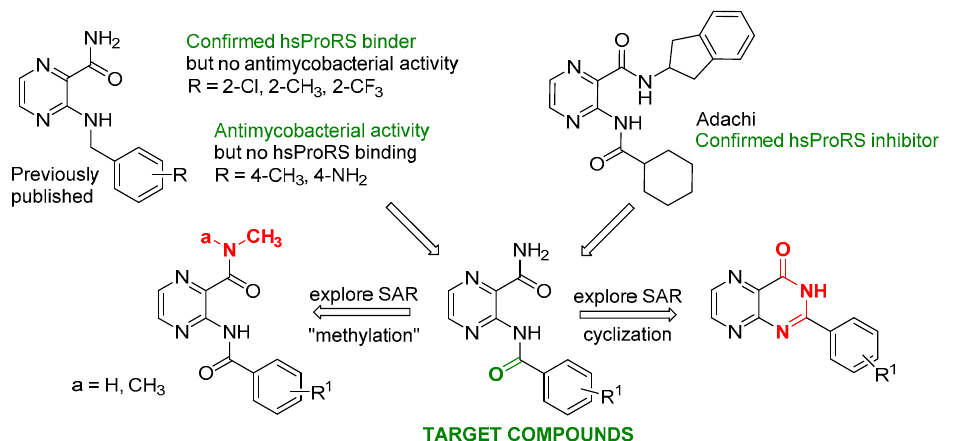
Figure 2. Design of the study. Red color denotes changes that were unfavorable for the activity.